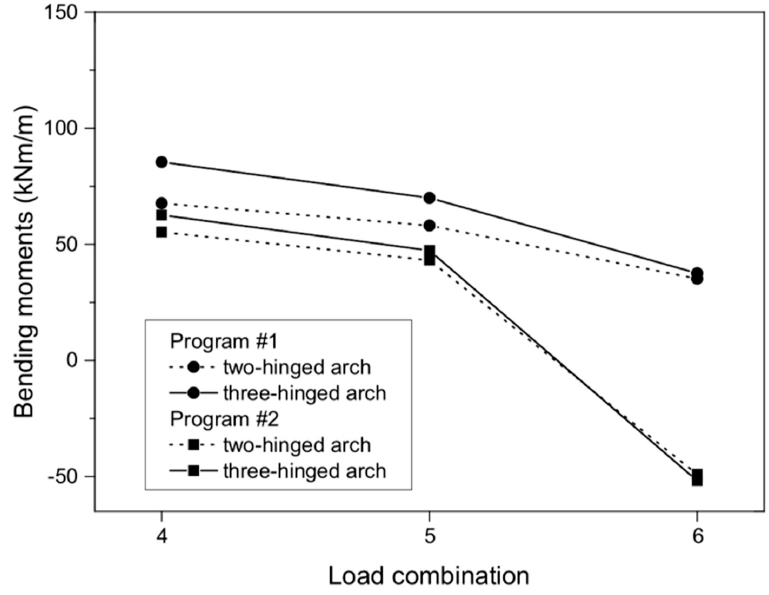
Figure 6. Bending moments of masonry arch viaduct for load combinations.